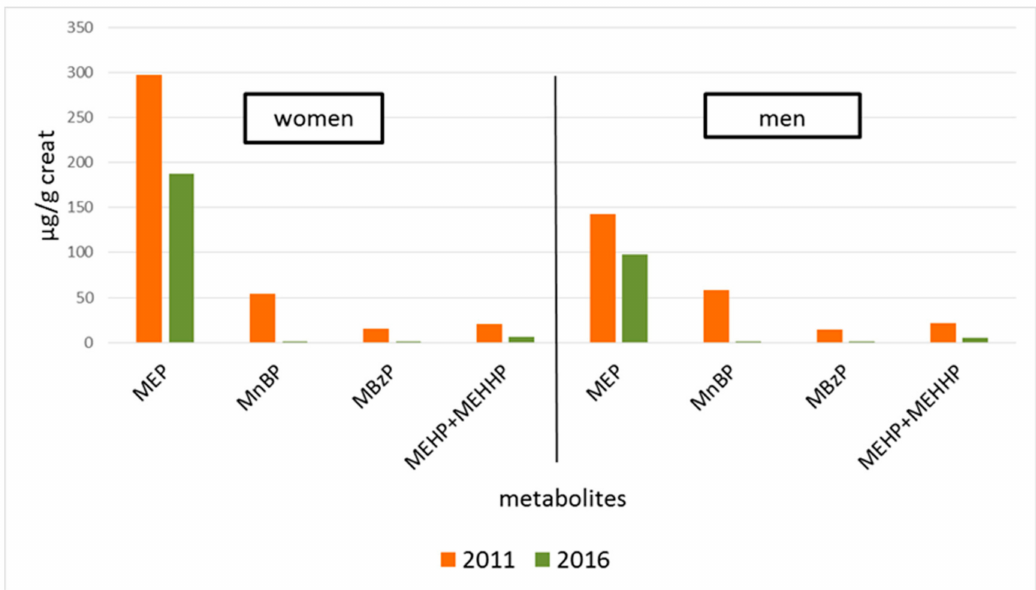
Figure 1. Comparison between periods, median data of urinary concentrations of phthalates’